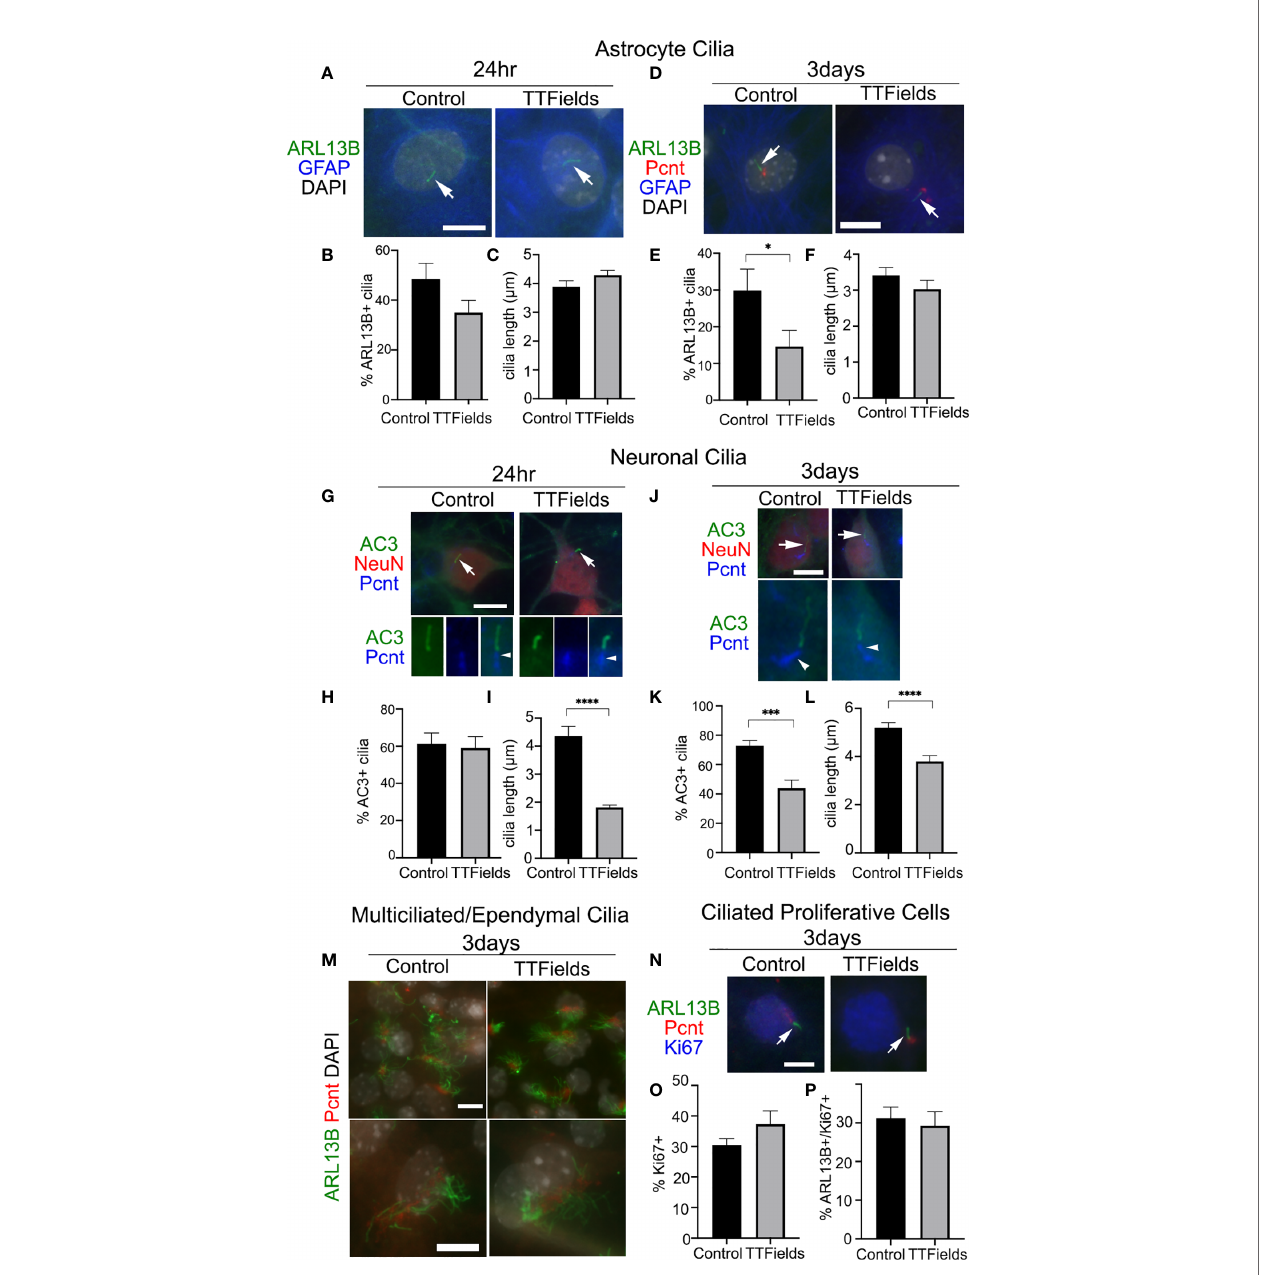
FIGURE 3 | Effects of TTFields on normal mouse neural cell types in vitro . Mixed primary cultures from neonatal mouse cerebral cortex were dissociated and maintained for 11DIV and left untreated (Control) or exposed to 24 h or 3 days of continuous TTFields and fi xed. (A) Cells were stained for ARL13B (green) and GFAP (blue) after 24 h TTFields. Nuclei were labeled with DAPI. Arrows point to ARL13B + cilia in both groups at 24 h. (B) Percent of GFAP + cells with ARL13B + cilia and (C) mean length of ARL13B + cilia on GFAP + cells after 24 h. (D) Cells were stained for ARL13B (green), pericentrin (Pcnt, red), and GFAP (blue) after 3 days of TTFields. (E) Percent of GFAP + cells with ARL13B + cilia and (F) mean length of ARL13B + cilia on GFAP + cells after 3 days. (G) Cells were stained for type 3 adenylyl cyclase (AC3) (green), NeuN (red), and Pcnt (blue) after 24 h TTFields. Nuclei were labeled with DAPI. The arrows in the upper panels point to cilia enlarged below each image showing Pcnt + basal bodies for indicated cilia. (H) Percent of NeuN + cells with AC3 + cilia and (I) mean length of ARL13B + cilia on NeuN + cells after 24 h TTFields. (J) Cells were stained for AC3 (green), NeuN (red), and Pcnt (blue) after 3 days of TTFields. The arrows in the upper panels point to cilia enlarged below each image which shows the Pcnt + basal bodies for indicated cilia. (K) Percent of NeuN + cells with AC3 + cilia and (L) mean length of ARL13B + cilia on NeuN+ cells after 3 days of TTFields. (M) Cells were stained with ARL13B (green) and Pcnt (red) with nuclei labeled with DAPI (white). Lower magni fi cation (upper panels) and enlarged (lower panels) examples of multiciliated cells in control (left panels) and 3 days of TTFields (right panels). Bars = 10 µm. (N) Cells were stained for ARL13B (green), Pcnt (red), and Ki67 (blue) after 3 days of TTFields. Images show examples of Ki67 + nuclei with ARL13B + cilia (arrows) extending from Pcnt + basal bodies. (O) Percent of Ki67 + cells per fi eld analyzed in each group. (P) Percent of Ki67 + cells with ARL13B + cilia. * p < 0.05; *** p < 0.001; **** p < 0.0001